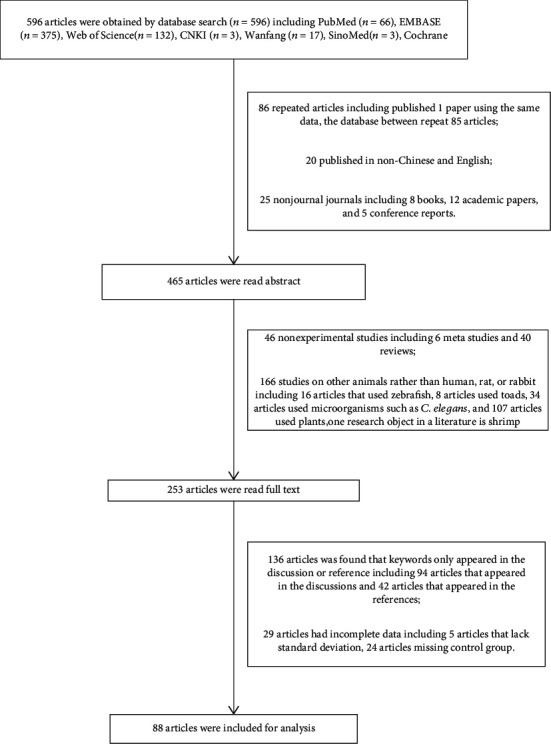
Search process and results.